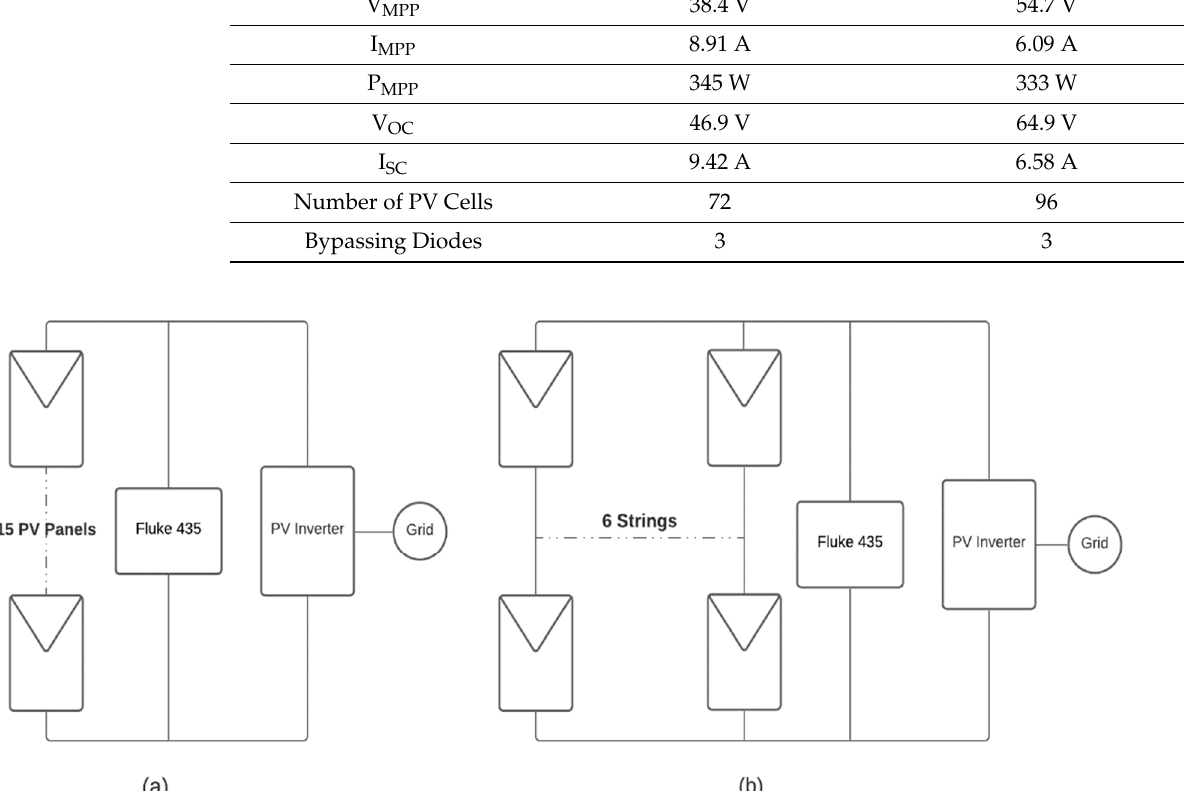
Figure 4. Experimental set-up of ( a ) a series PV array and ( b ) a series–parallel PV array.